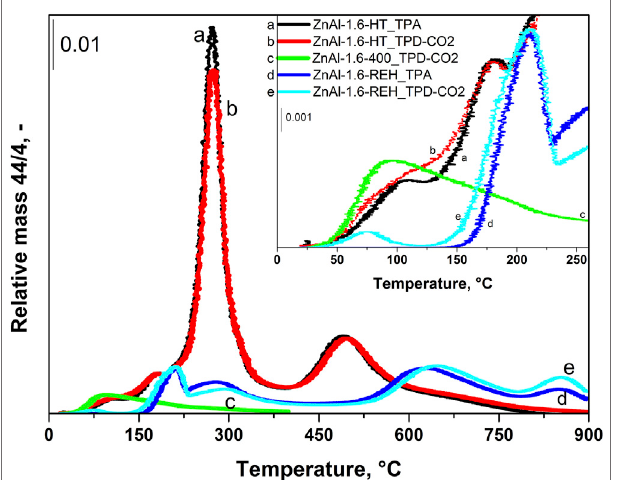
FIGURE 6 | TPD-CO 2 pro fi les of ZnAl-1.6-HT hydrotalcite, ZnAl-1.6-400 mixed oxide, ZnAl-1.6-REH reconstructed LDH and TPA (experiment without CO 2 adsorption) pro fi les of ZnAl-1.6-HT hydrotalcite and ZnAl-1.6-REH RE-LDH.